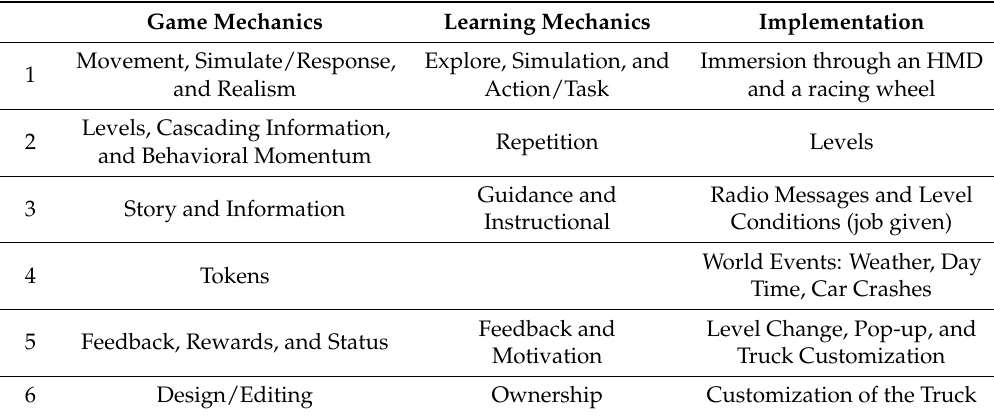
Table 1. Game and learning mechanics of the simulator, based on the LM-GM model. Game